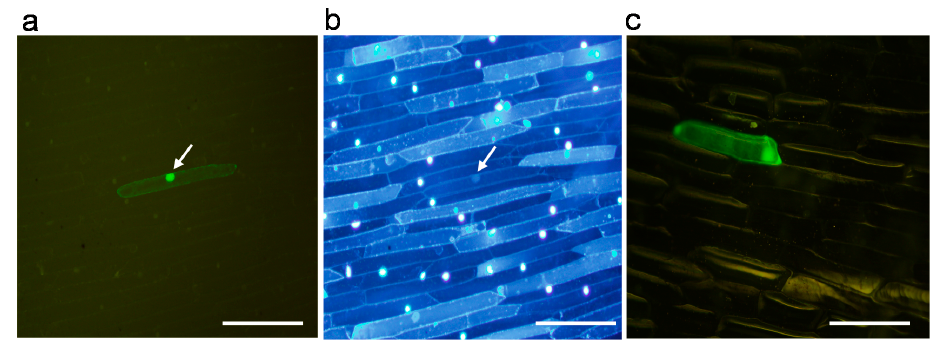
Figure 3. Nuclear localization of GFP/OsY37 I fusion protein in onion epidermal cells. The GFP/OsY37 I gene ( a , b ) and GFP ( c ) constructs under the control of the CaMV35S promoter (clone pGFOSY) were introduced into onion epidermal cells by particle bombardment. Intracellular localization of the GFP protein after 24 h was examined by fluorescence microscopy ( a , c ). Nuclei were stained with 4 ′ ,6- diamidino-2-phenylindole dihydrochloride (DAPI) ( b ). Arrows indicate the nucleus where accumulation of GFP was observed. Bar = 500 µm